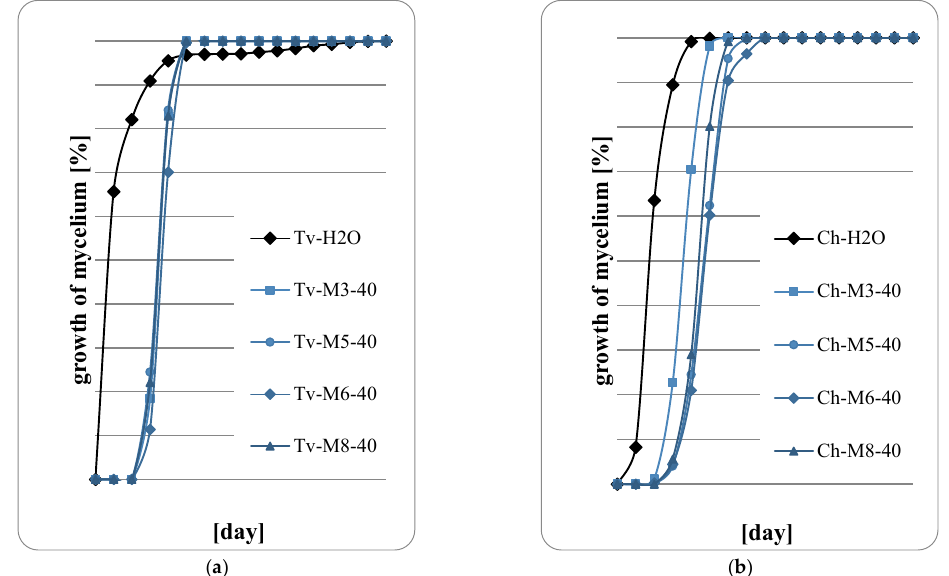
Figure 8. Fungal growth on wood: ( a ) T. viride ; ( b ) Ch. globusom (explanation of symbols in the legend: Ch-H20—control, 40—sample code indicating the application of 1000 g of extract per m 2 , M3— M. spicata ‘Morocco’, M5— M. spicata ‘Crispa’, M6— M. × piperita ‘Almira’, M8— M. suaveolens ’